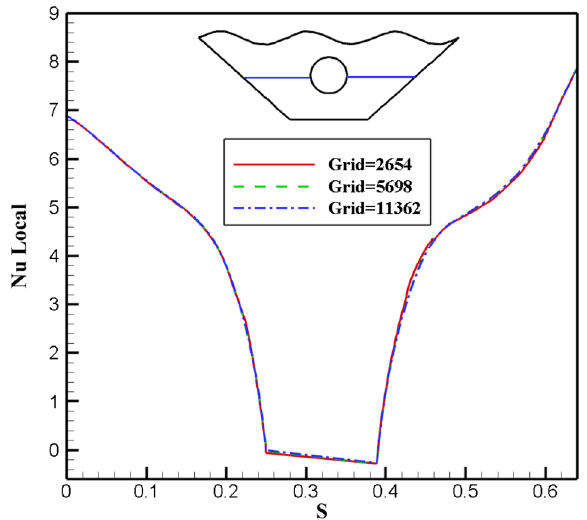
Figure 4. Comparison of the local Nu number for different grid sizes when Ra = 500, Ha = 20, ε = 0.7, Rd = 0.5, α = π/ 6